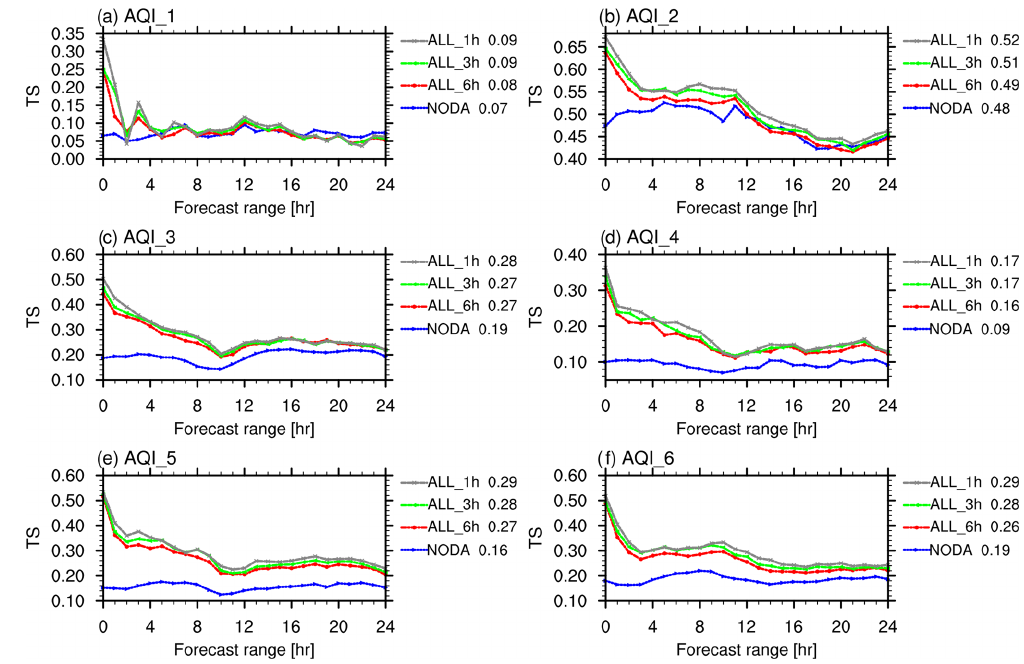
Figure 12. Same as Fig. 8, but for the experiments NODA, ALL_6h, ALL-3h, and ALL_1h,